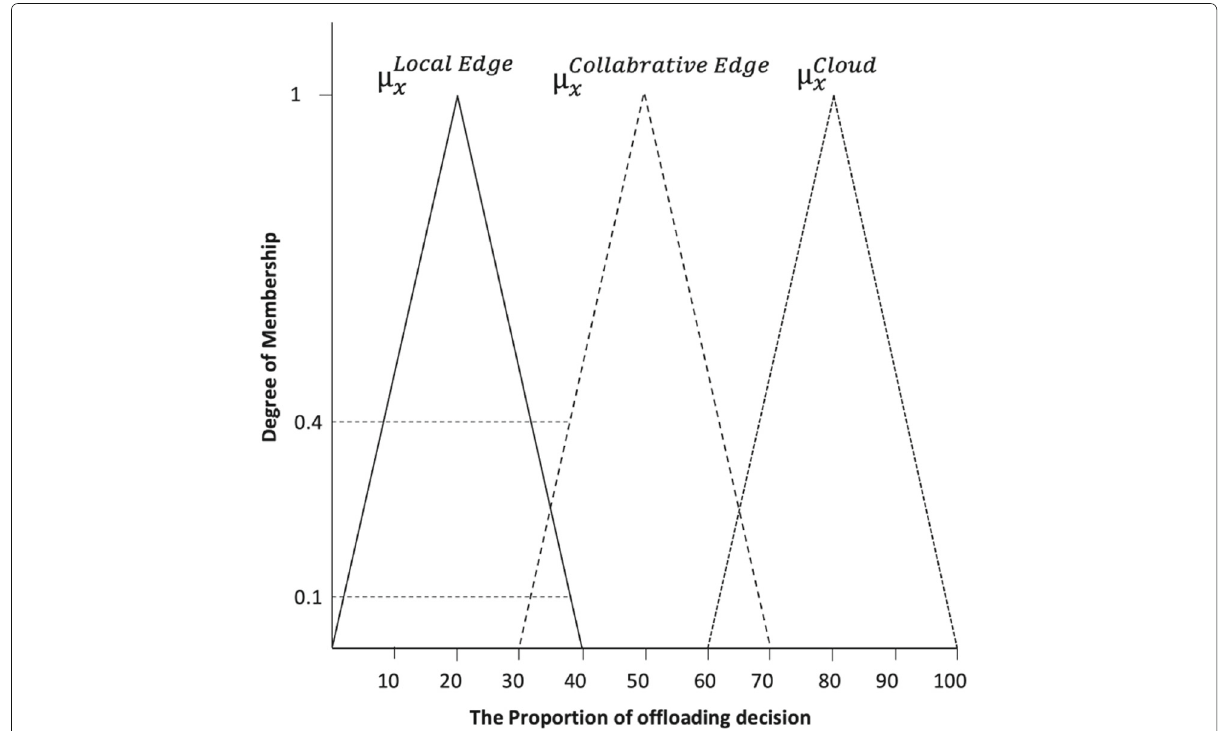
Fig. 5 The output membership function of the fuzzy logic system